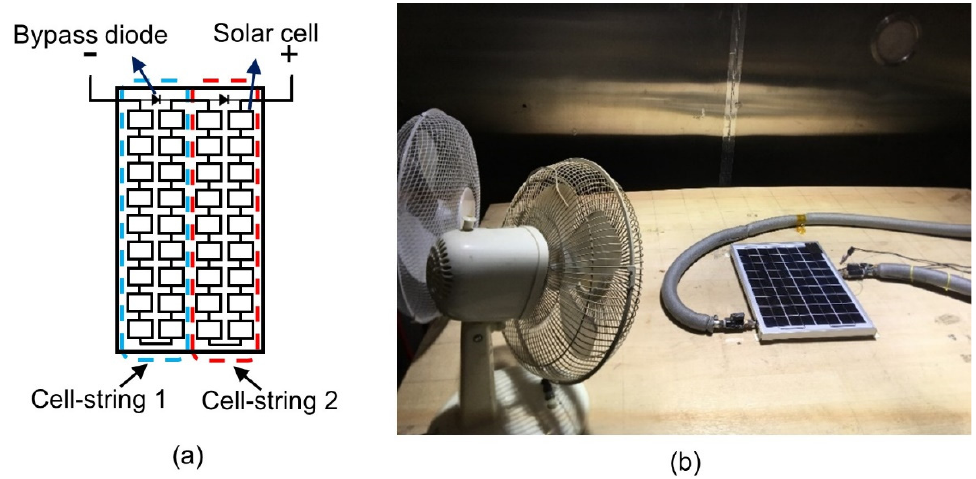
Figure 3. The 10 W PV module: ( a ) The configuration of the cells and bypass diodes. The blue box represents cell-string 1 and the red box represent cell-string 2. ( b ) The module testing assembly connected to the water cooling and under shading experiments.